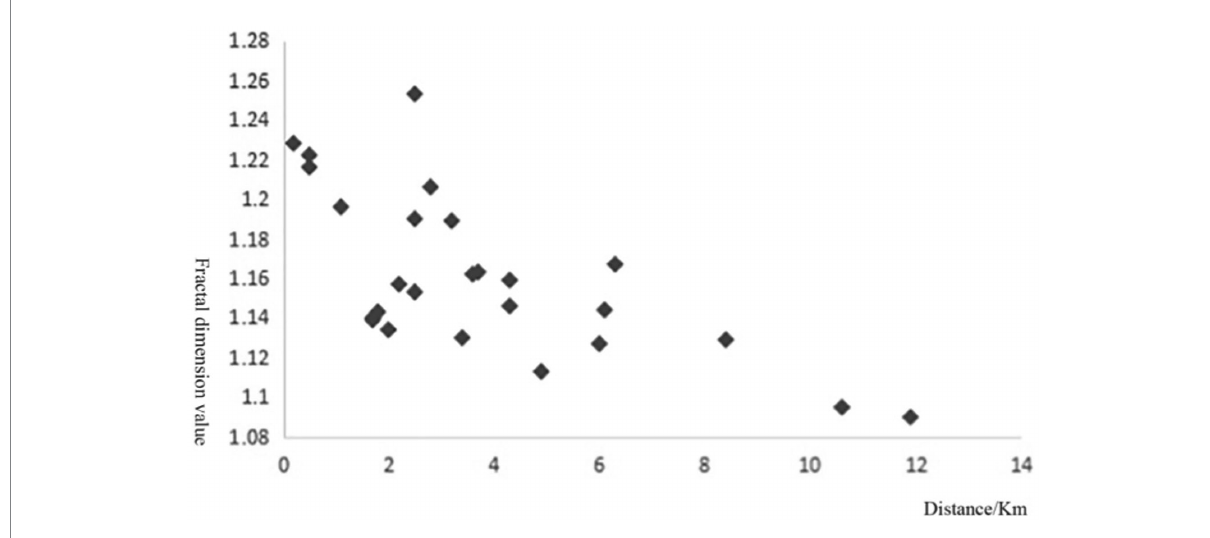
FIGURE 8 Scatter plot of water body plans in dimensional values and